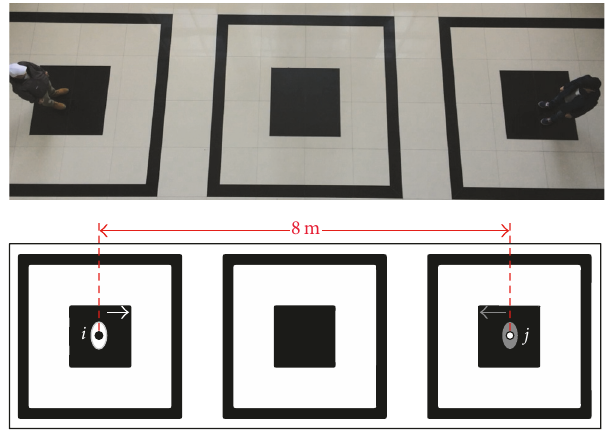
Figure 1: The collision-avoidance behavior experiment scenario. The distance between pedestrians 𝑖 and 𝑗 is 8 meters. Pedestrian 𝑖 walks from the left side of the scenario to the right side, and pedestrian 𝑗 walks from the right side of the scenario to the left side. They keep moving until they reach the initial position of the other